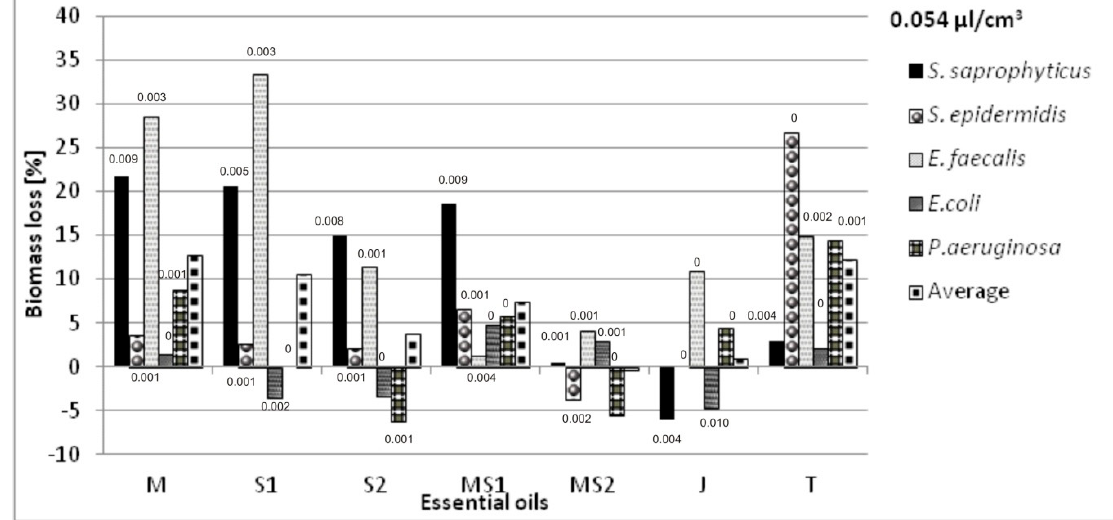
Figure 3. Antimicrobial activity of essential oils in a vapor phase at the oil concentration of 0.054 µ L/cm 3 in the atmosphere, where: M— Matricaria chamomilla L.; S1— Salvia officinalis L.; S2— Salvia lavandulaefolia Vahl.; MS1— Matricaria chamomilla L. with Salvia officinalis L.; MS2— Matricaria chamomilla L. with Salvia lavandulaefolia Vahl.; J— Juniperus communis L.; T— Thymus vulgaris L. Results are presented as an average value of three repetitions with ± SD < 0.01 (values of SD placed above the bars); all the results were statistically different ( p <